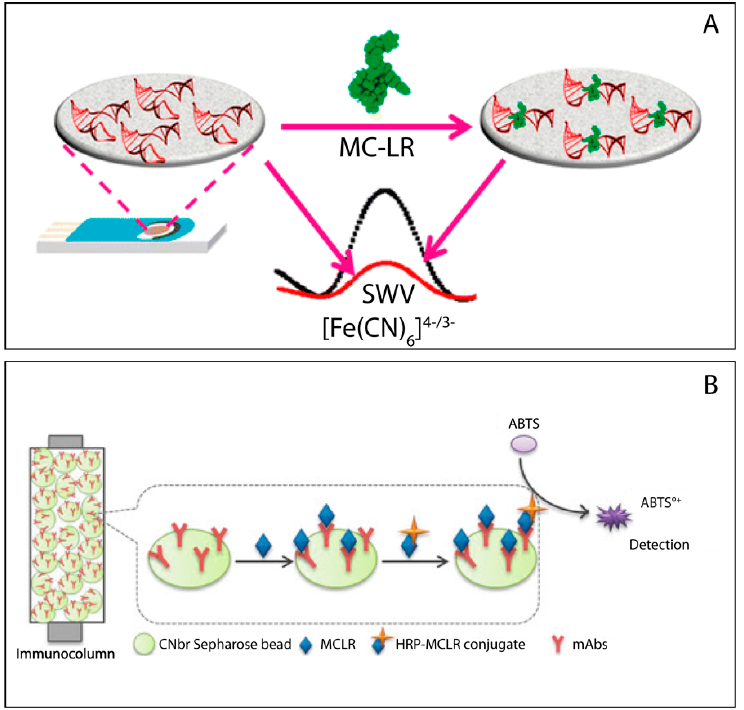
Figure 2. ( A ) Schematic of MC-LR Detection Based on SWV on Aptamer-Functionalized GSPE. Reprinted with permission from Ref. [42]. Copyright 2014, American Chemical Society; ( B ) Schematic demonstration of the extraction taking place in the immunocolumn. Reprinted from ref.